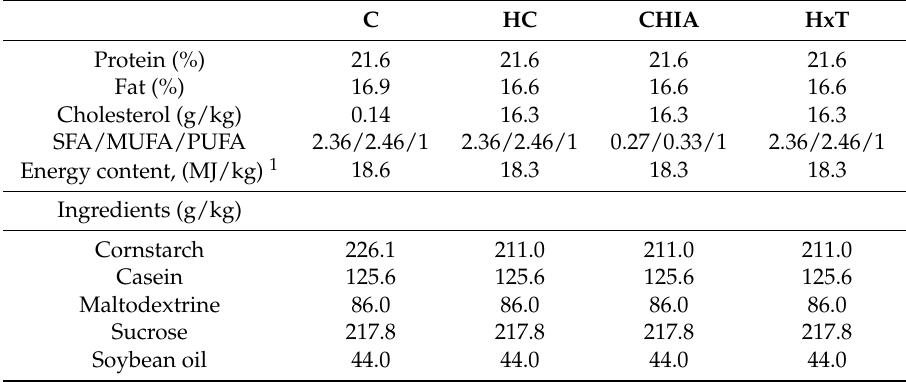
Table 1. Composition of the experimental